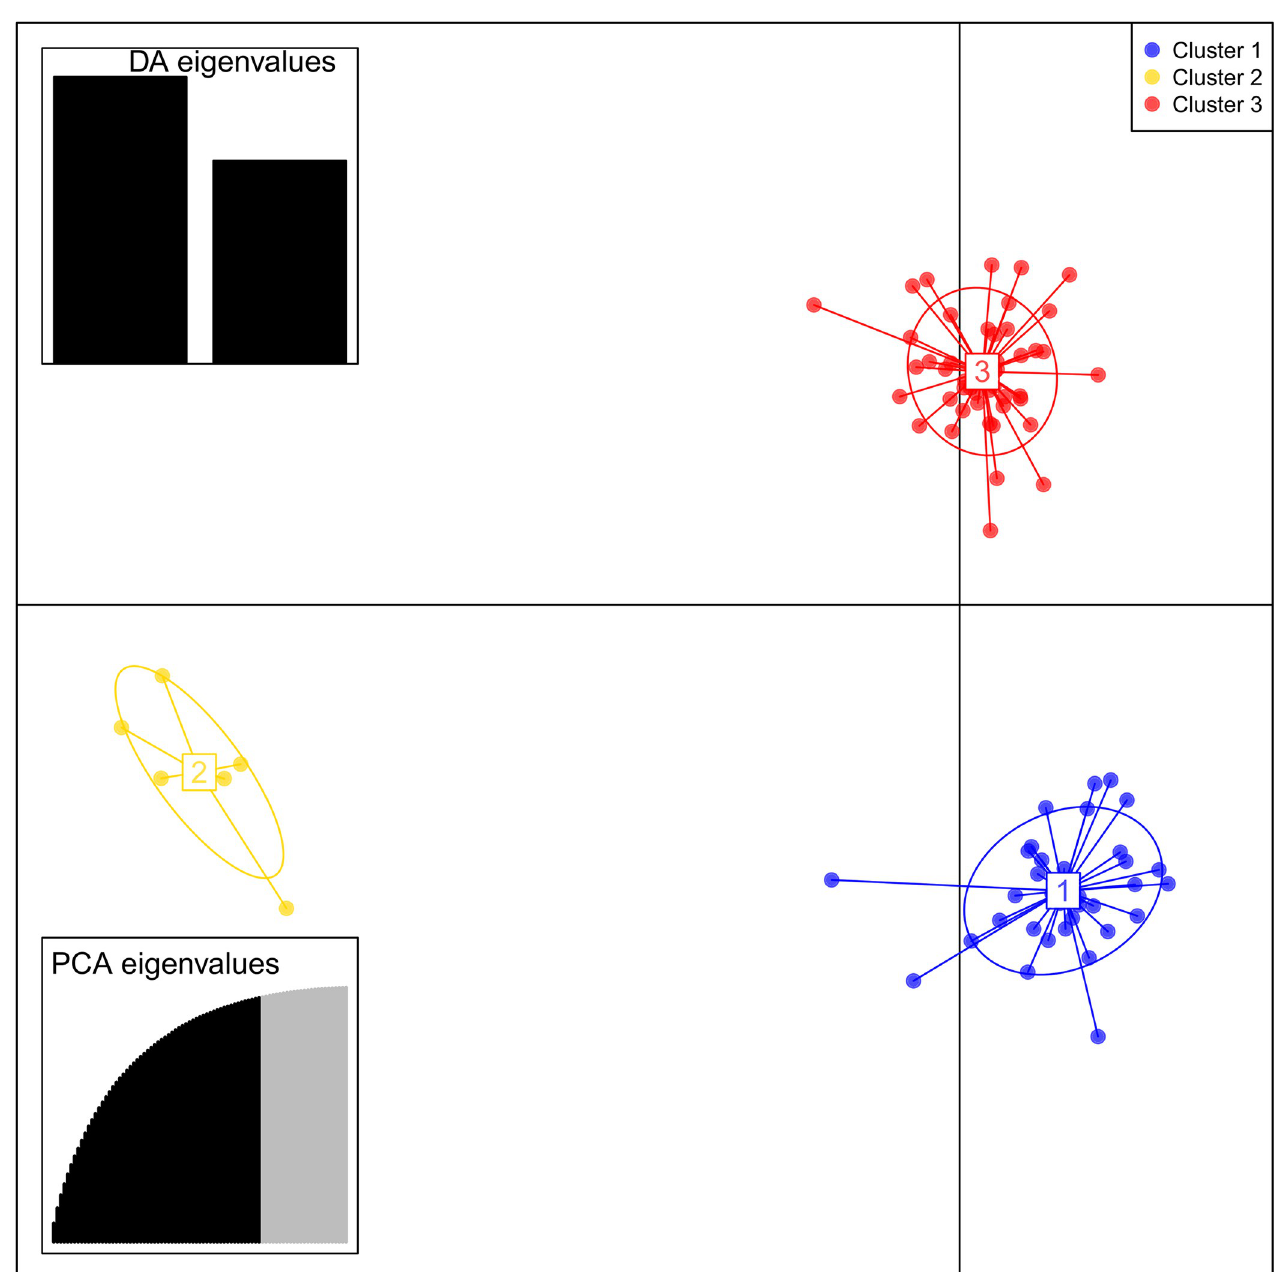
Fig 2. The discriminant analysis of principal components (DAPC) of different wild ancient tea tree populations. The obtained graph represents the individuals as dots and the groups as inertia ellipses. Eigenvalues of the analysis are displayed in inset.